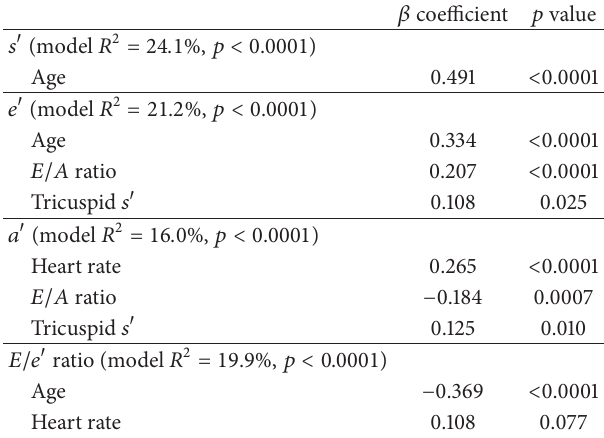
Table 5: Independent predictors of left ventricular longitudinal indexes in the study population, calculated as the average of septal and lateral values.